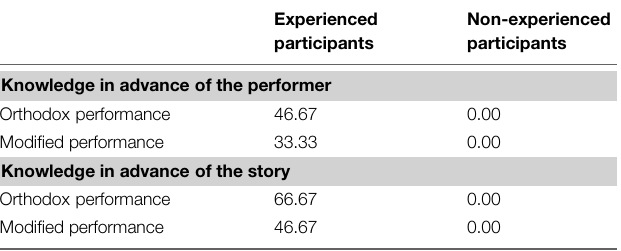
TABLE 1 | Percentages of participants with knowledge of the performer and the